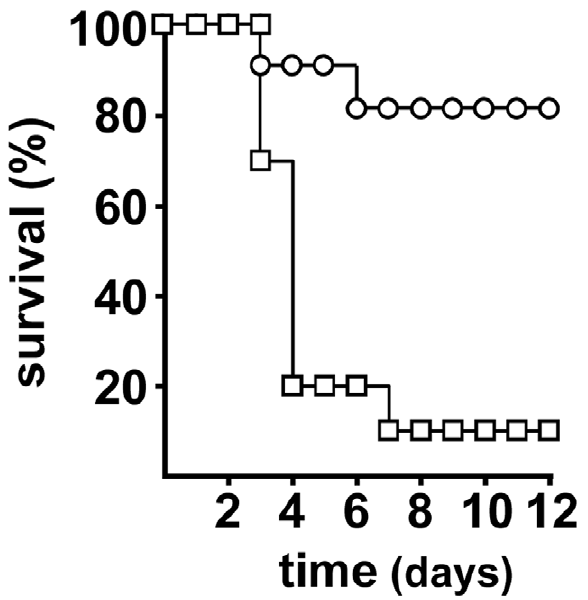
Figure 1. Effect of the Y.pestis Ybt on transmission by fleas. Incidence and time to terminal disease in mice bitten by fleas infected with Y. pestis wild type (open squares) or the D irp2 mutant (open